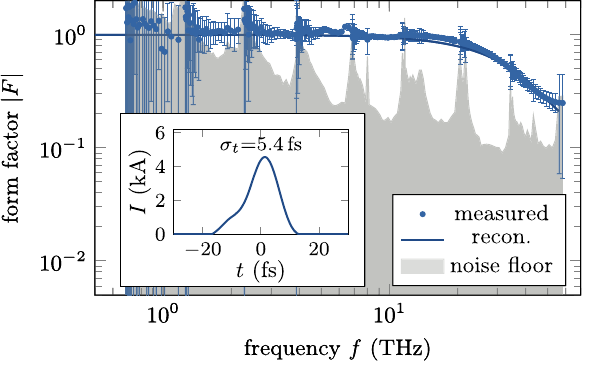
FIG. 8. Measured form factor of the ultrashort bunch, which was used to correct the high frequency channels, together with reconstructed current profile (inset) and corresponding form factor.